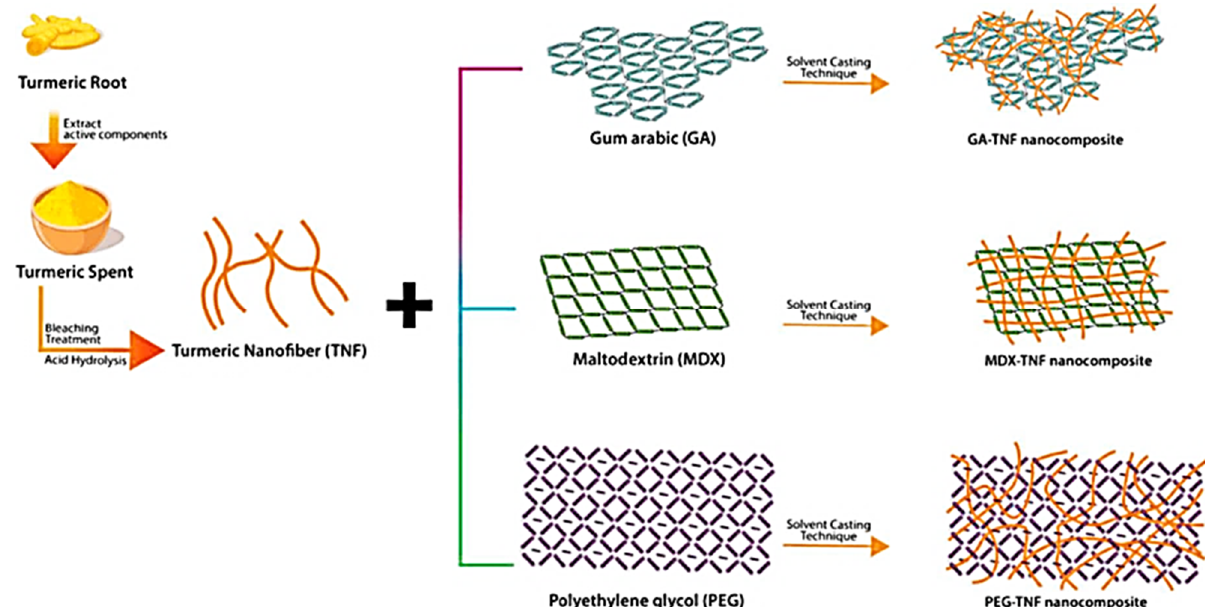
Figure 2. Schematic of the preparation steps for turmeric nanofiber-based nanocomposites [64]. Reproduced with permission from Elsevier.